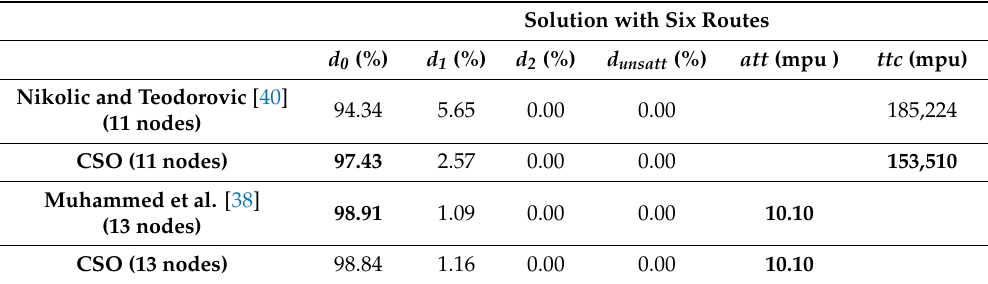
Table 10. Comparative results for the best six-route solutions for Mandl’s network.